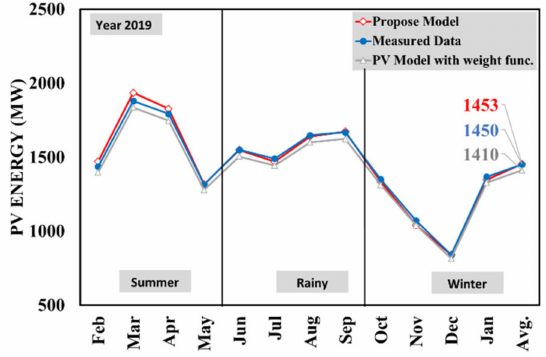
Figure 16. Comparison of the PV energy of the simulated and measured data of the different seasons.